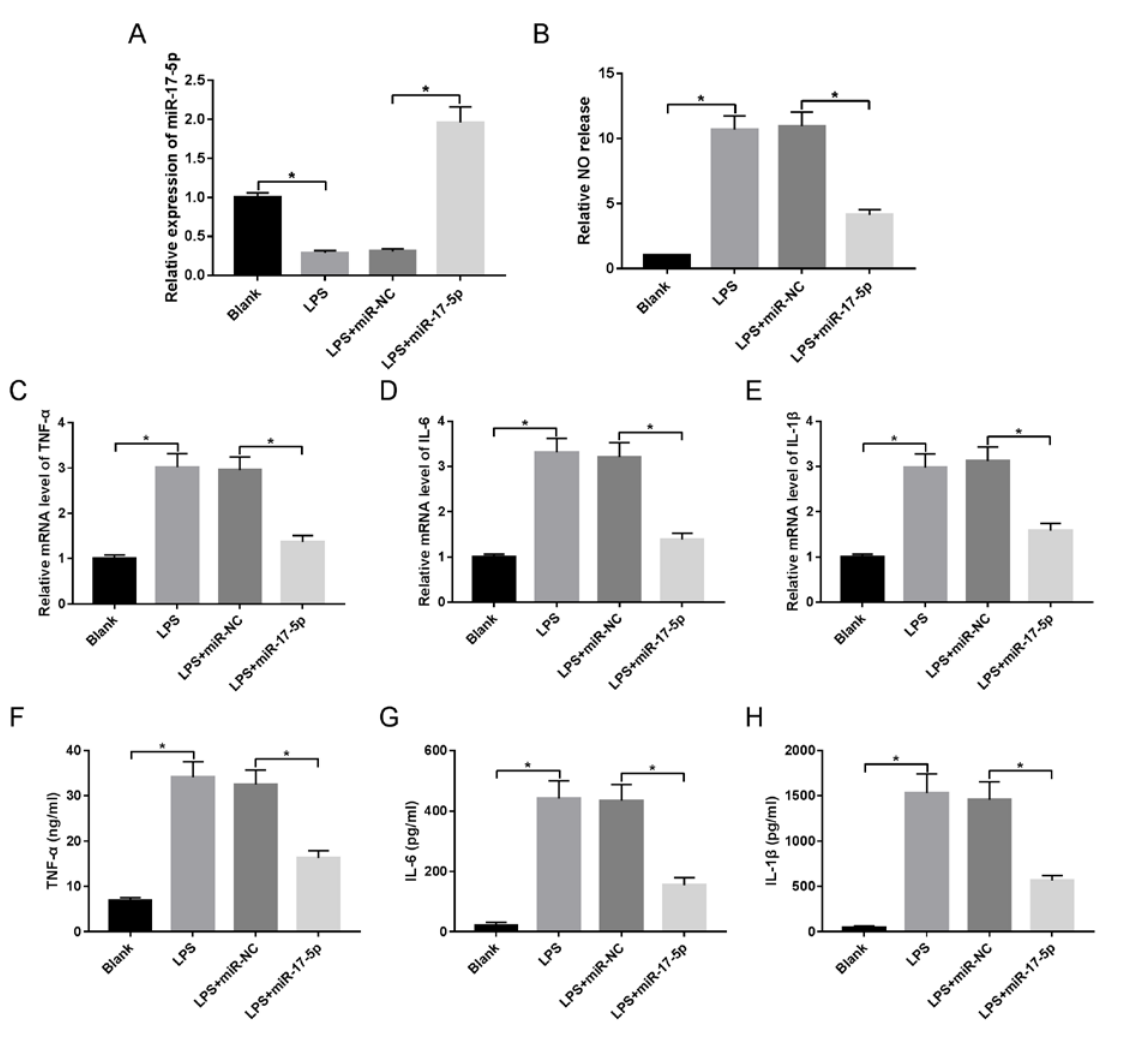
Figure 4: miR-17-5p overexpression suppresses LPS-induced inflammatory injury in macrophages. Macrophages were transfected with miR-NC or miR-17-5p and then treated with LPS. miR-17-5p expression (A), NO release (C) and inflammatory cytokine expressions (C-H) were measured in transfected cells.